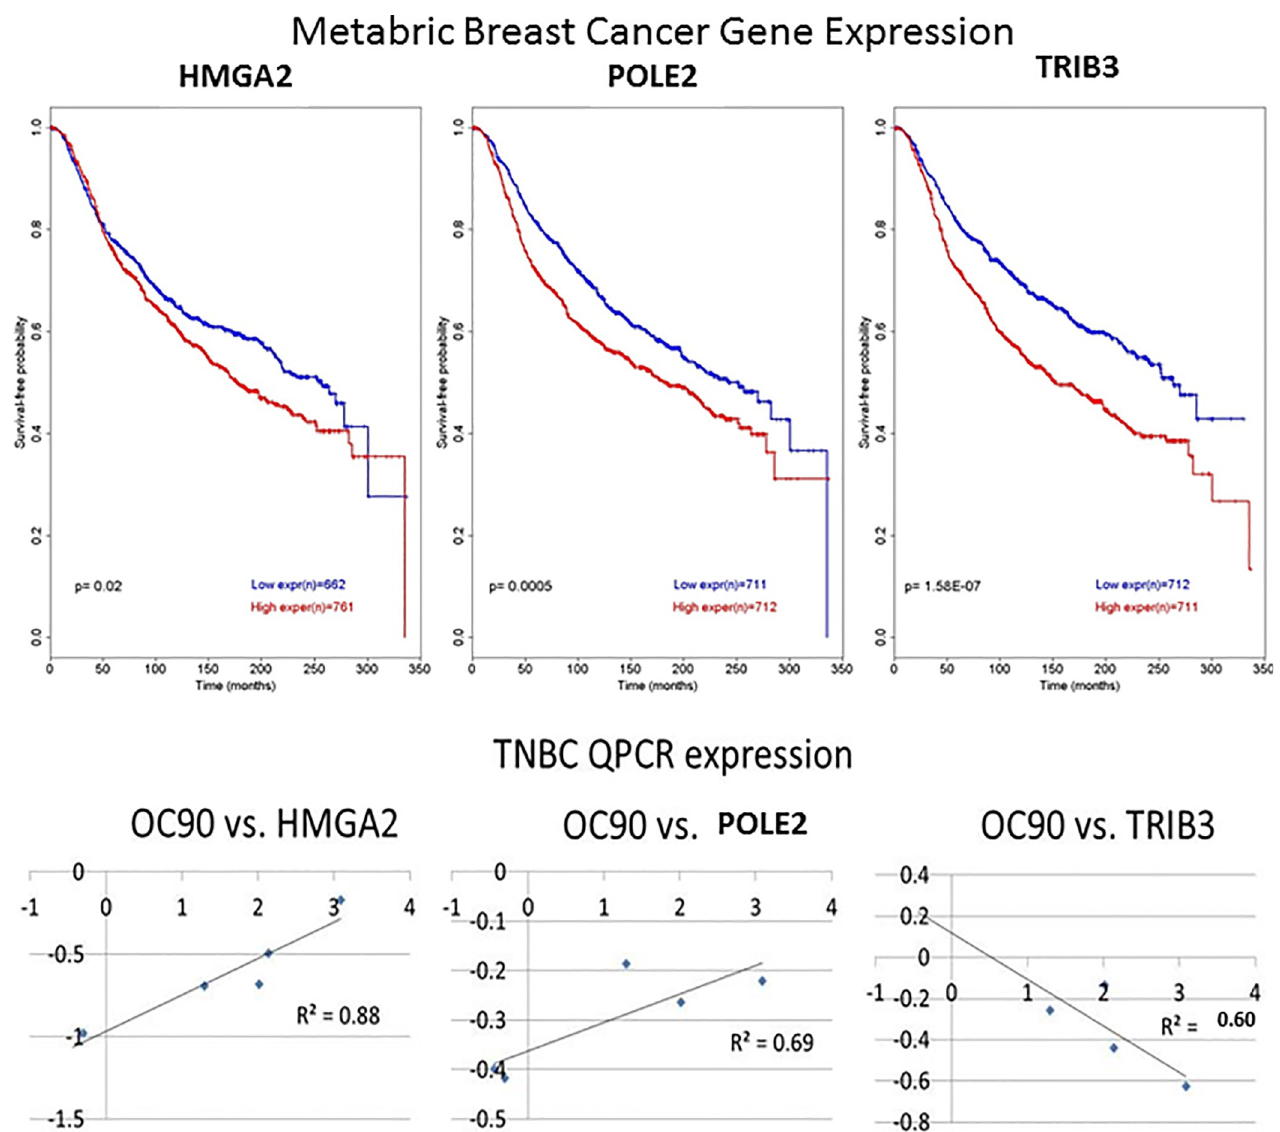
Fig 7. Genes demonstrating co-expression with OC90 in breast cancer predict metastasis-free survival. A) Kaplan Meier estimation of overall survival probability with OC90 co-expressed genes, HMGA2 (left panel), POLE2 (middle panel), TRIB3 (right panel). B) qPCR demonstrating co-expression with OC90 in TNBC. Linear regression of BT20, BT549 and HCC38 under basal, knockdown and overexpression conditions (left panel OC90 vs. HMGA2, middle panel OC90 vs. POLE2, right panel OC90 vs.